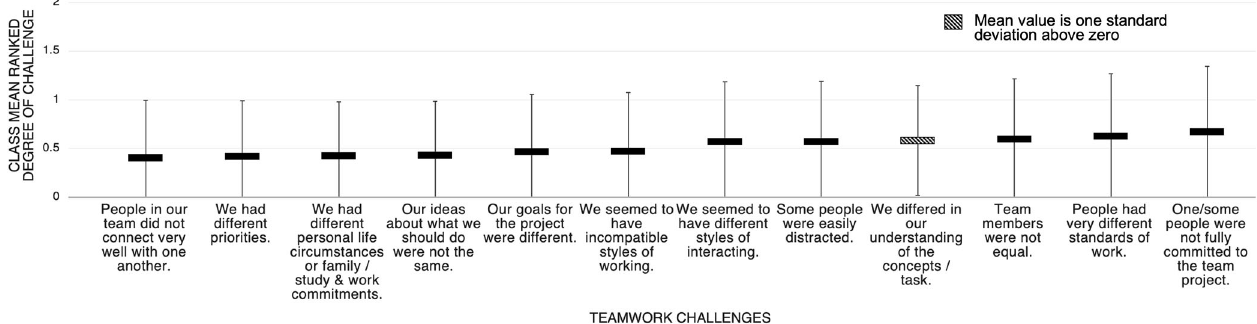
FIG. 3. Students were asked to rank the “ degree of difficulty ” for each of the challenges on the AIRE survey. We plot the mean reported value of all the respondents where 2 is extremely or very challenging, 1 is moderately or slightly challenging, and 0 is not challenging at all. The whiskers represent plus and minus 1 standard deviation and the height of the bar is the standard error of the mean.